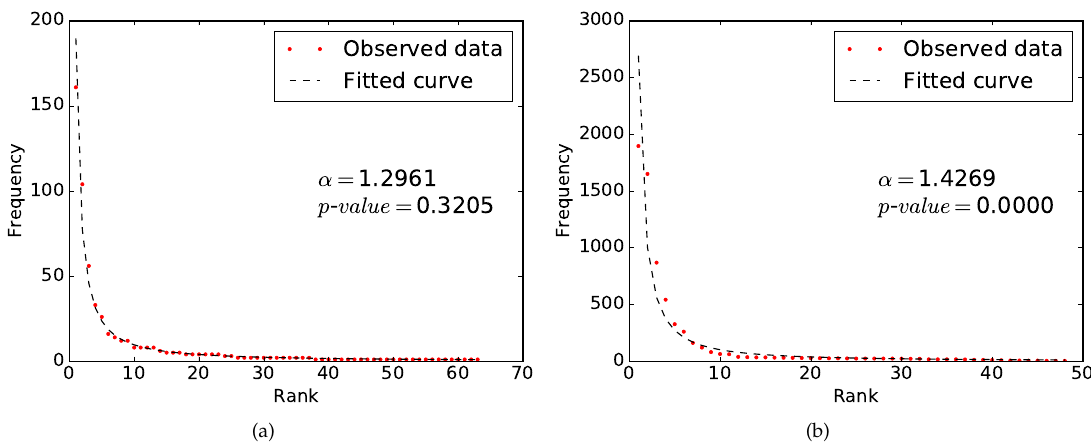
Figure 6. Maximum likelihood estimation (MLE) fitting results. ( a ) Medical Parasitology in the xuetangX dataset; ( b ) Mechanics Review in the edX